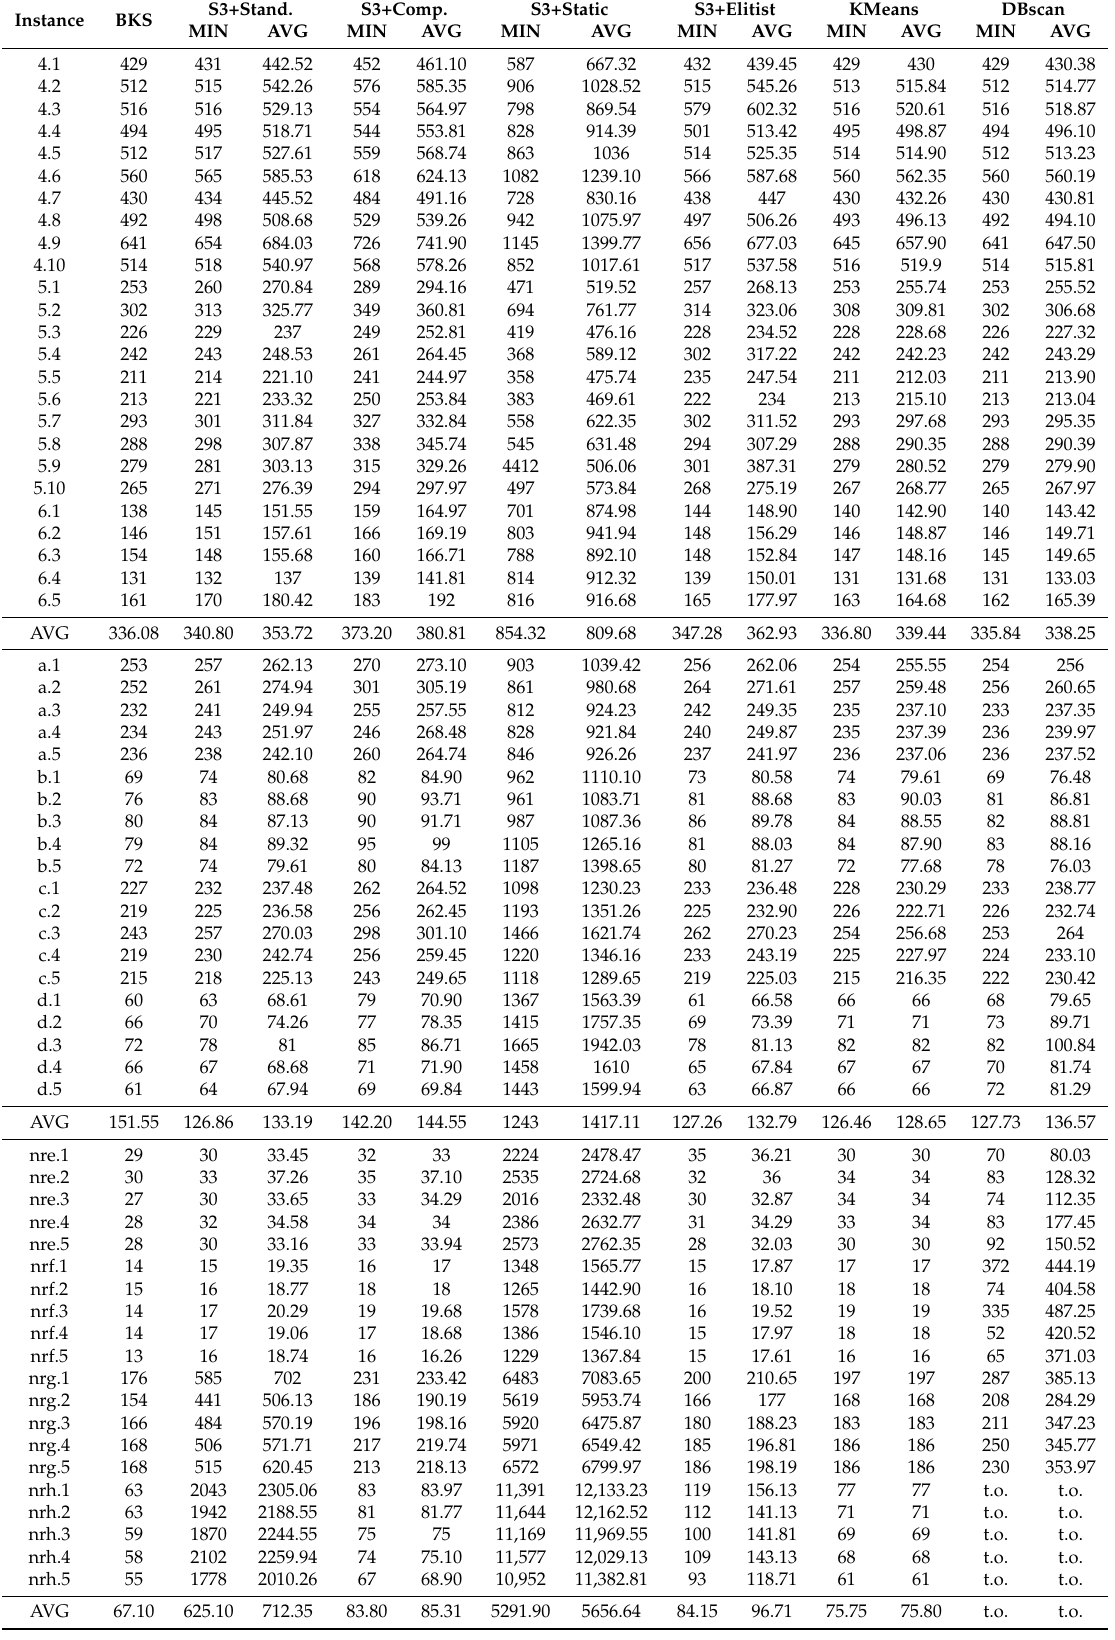
Table A3. CSA/SCP—SShape 3—Two-steps vs. KMeans vs. DBscan (t.o = time